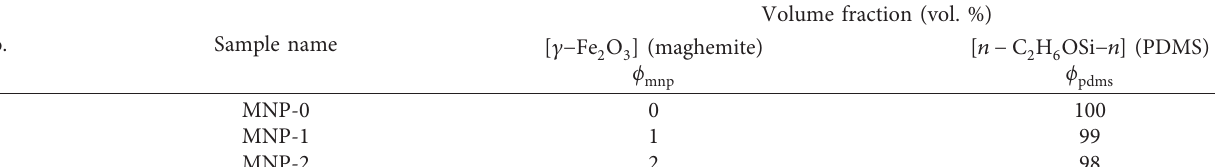
Table 1: Composition of the samples.